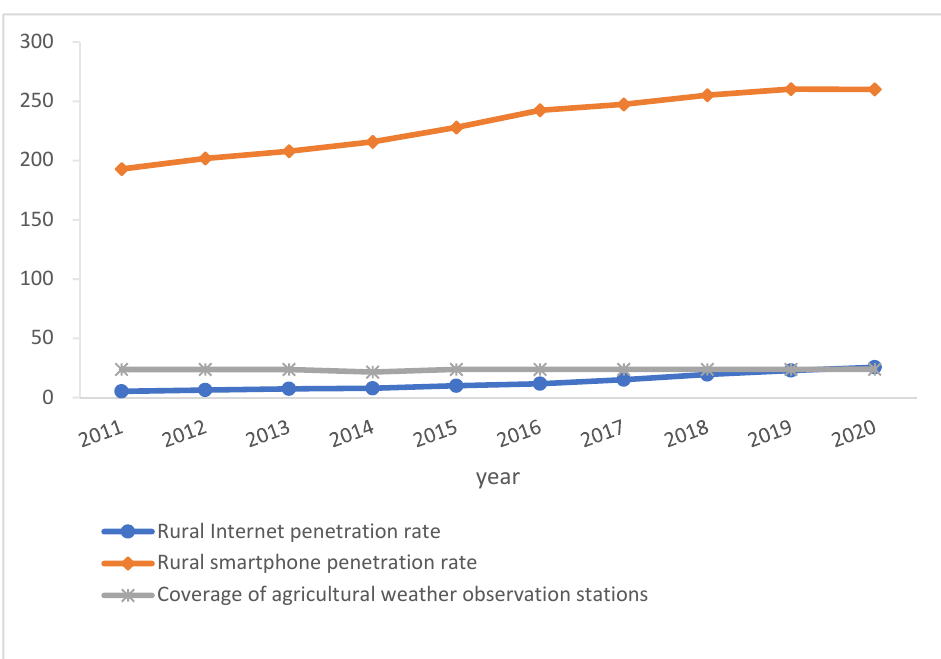
Figure 2. The rural Internet penetration rate, smartphone penetration rate and the average develop- ment level of agrometeorological observation stations in 2011–2020.